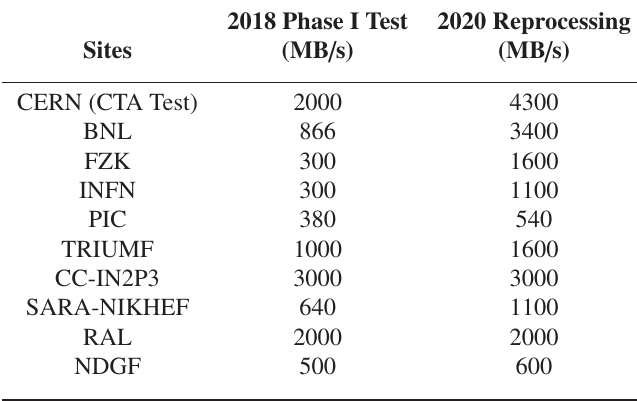
Table 1: Stable Rucio tape throughput for the ATLAS Tier-1 sites and CERN, measured from the 2020 reprocessing campaign, with comparison to the Phase I